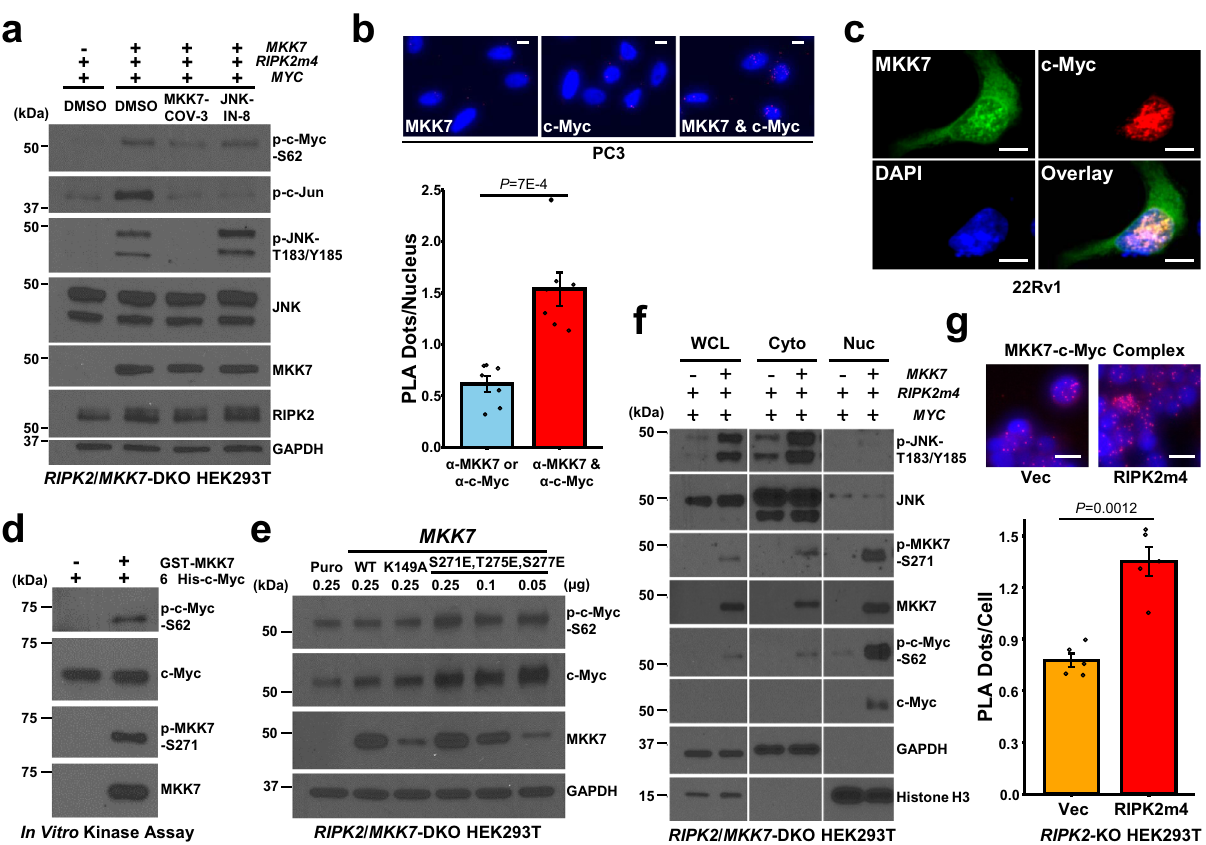
Fig. 7 MKK7 is a direct c-Myc-S62 kinase. a Representative immunoblots of the indicated proteins in total lysates of RIPK2 / MKK7 -DKO HEK293T cells, which were transiently co-transfected with 0.5 µ g MYC , 0.5 µ g RIPK2m4 , and 0.1 µ g MAP2K7 or vector plasmids and then treated with vehicle control, MKK7-COV-3 (25 µ M), or JNK-IN-8 (1 µ M) in 10% FBS-containing medium for 2 h. b Representative images (upper) and quanti fi cation (lower) of PLA detecting the association of endogenous MKK7 and c-Myc in PC3 cells ( n = 7 biologically independent samples per group). Scale bars, 10 μ m. c Representative images of immuno fl uorescence colocalization of MKK7 and c-Myc in RIPK2 / MKK7 -DKO 22Rv1 cells, which were transiently co- transfected with RIPK2m4 , MKK7-His , and MYC plasmids. Scale bars, 10 μ m. d Representative immunoblots of the indicated proteins after in vitro kinase reactions. e Representative immunoblots of the indicated proteins in total lysates of RIPK2 / MKK7 -DKO HEK293T cells, which were transiently transfected with the indicated forms of MKK7 plasmids or vector control. f Representative immunoblots of the indicated proteins in total lysates, cytoplasmic fraction, and nuclear fraction of RIPK2 / MKK7 -DKO HEK293T cells, which were transiently co-transfected with RIPK2m4 , MYC , and MKK7 or vector control. WCL: whole-cell lysate; Cyto: cytoplasmic; Nuc: nuclear. g Representative images (upper) and quanti fi cation (lower) of PLA detecting the MKK7-c-Myc complex in RIPK2 -KO HEK293T cells, which were transiently transfected with MYC and RIPK2m4 or vector control ( n = 5 biologically independent samples per group). Scale bars, 20 μ m. Nominal p- values were determined by unpaired two-tailed Student ’ s t -test ( b , g ). Data are Mean ± SEM ( b , g ).